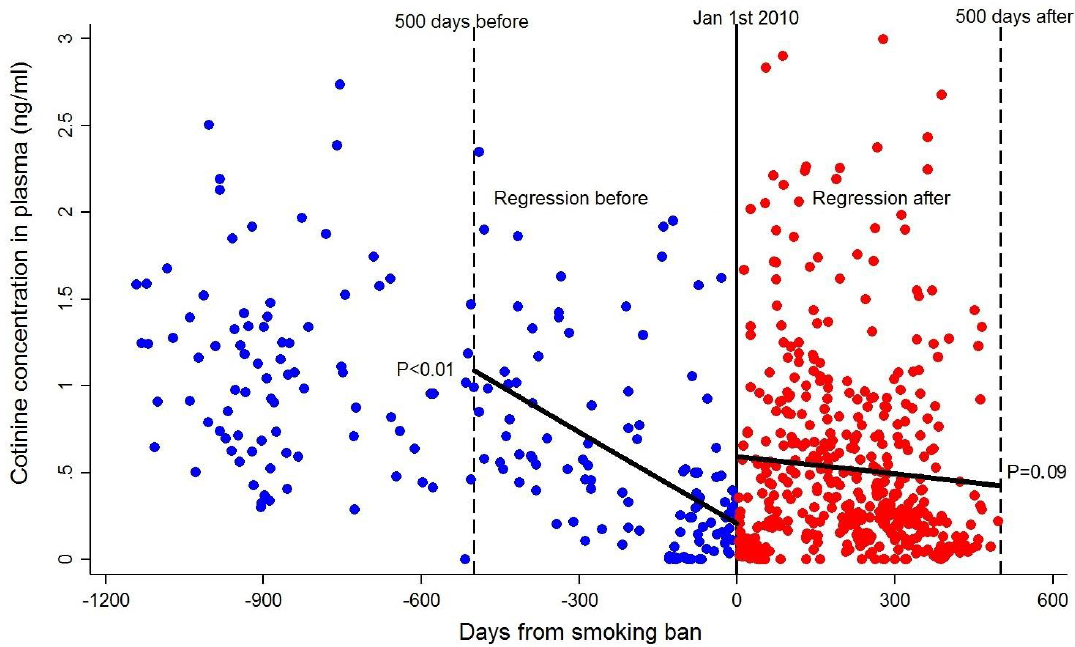
Figure 1. Levels of cotinine among non-smoking (i.e., cotinine levels ≤3 ng/mL) pregnant women before ( N = 200, mean = 0.78, SD = 0.60) and after ( N = 468, mean = 0.52, SD = 0.55) implementation of the 2010 smoking ban. Data are plotted from the exact day (2 January 2010) that the ban was implemented. Results from the regression discontinuity analyses are also displayed. Restricting the data to 500 days before the ban ( N = 114) and 500 days after the ban ( N = 464), results indicate a significant decline in cotinine values in the days prior to implementation of the smoking ban and a non-significant decline following the ban.